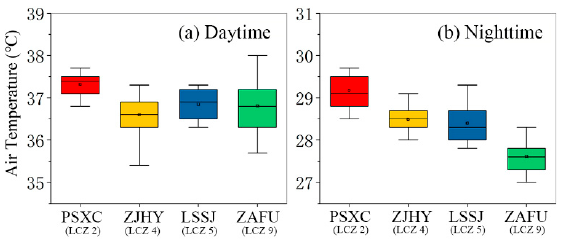
Figure 4. The box plots of the air temperature in each LCZ at different times. ( a ) Daytime, ( b ) night- time. The bulging dots in the middle illustrate the median values.